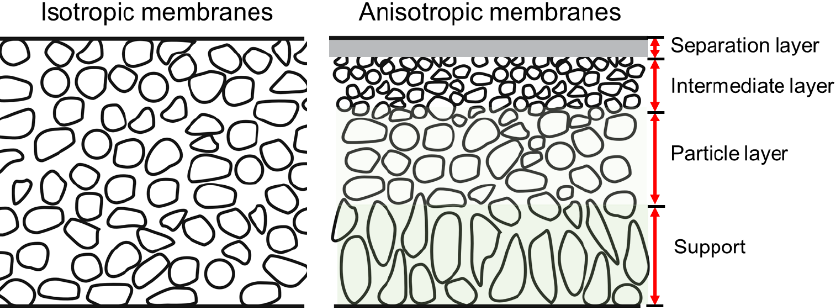
Figure 2. Schematic of isotropic and anisotropic membranes [38] . SiC membrane filters usually consist of multiple layers on macroporous supports.